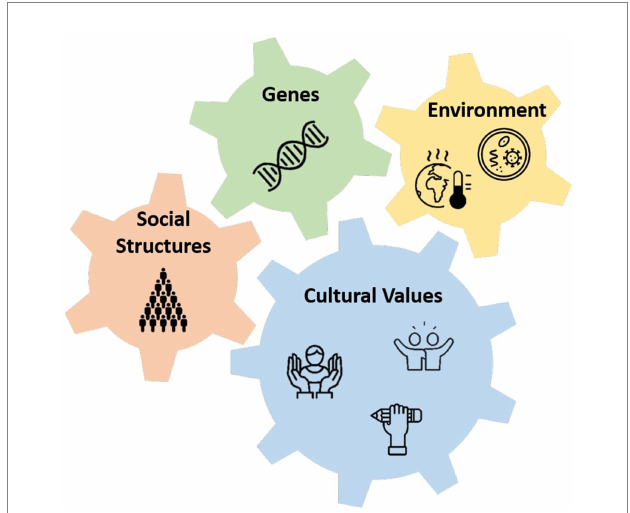
FIGURE 2 Socio-cultural evolutionary explanation of the gender equality paradox. The gears show the interrelations between gender-specific genes, social structures, and environmental components mediated by cultural